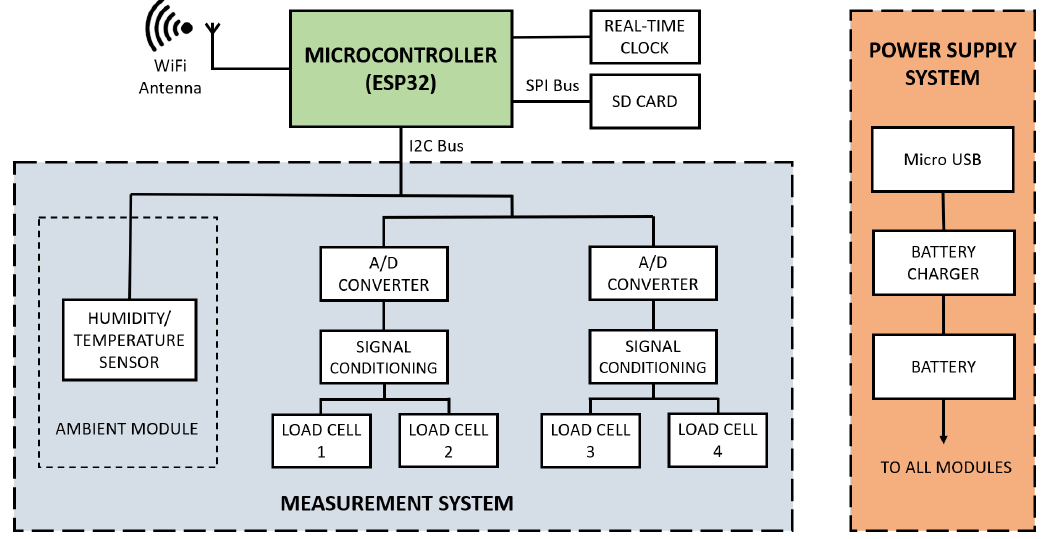
Figure 2. Block diagram of the data acquisition system: microcontroller, Measurement System (system parameter measurement), and Power Supply System.